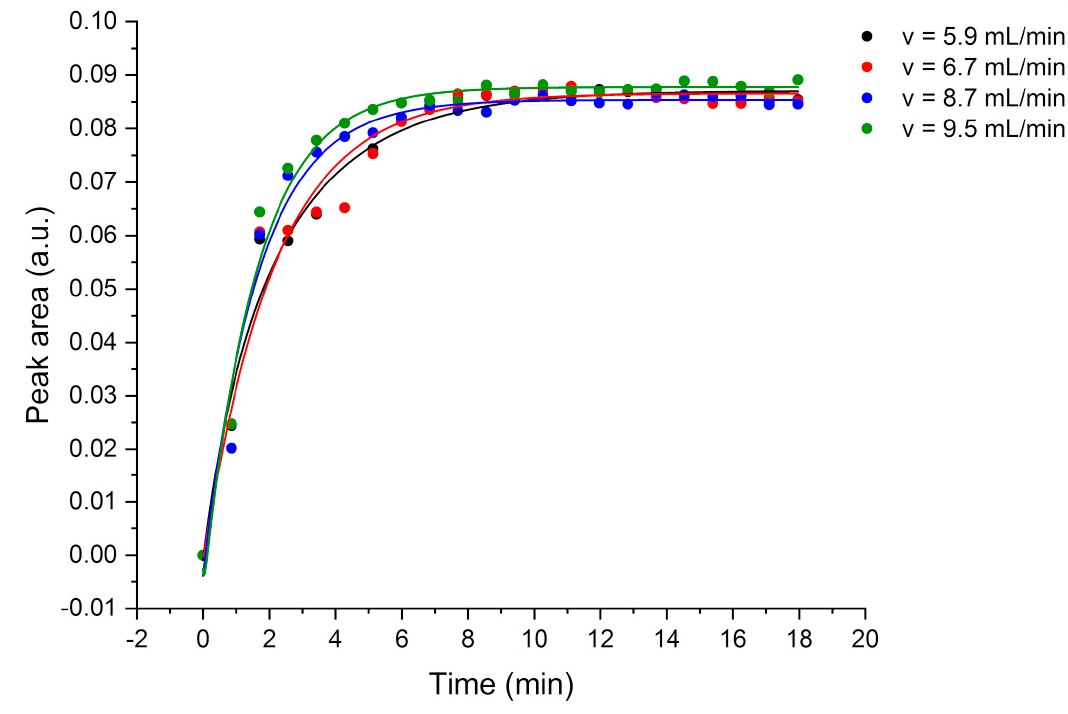
Figure 8. Comparison of enrichment curves at different flow rates exemplarily shown for EB at a concentration of 15 ppm. Black: 5.9 mL/min, red: 6.7 mL/min, blue: 8.7 mL/min, green: 9.5 mL/min. Table 7. Overview of coe ffi cients for exponential fits and t 90 -value for enrichment functions of EB at 5.9, 6.7, 8.7, and 9.5 mL/min a .